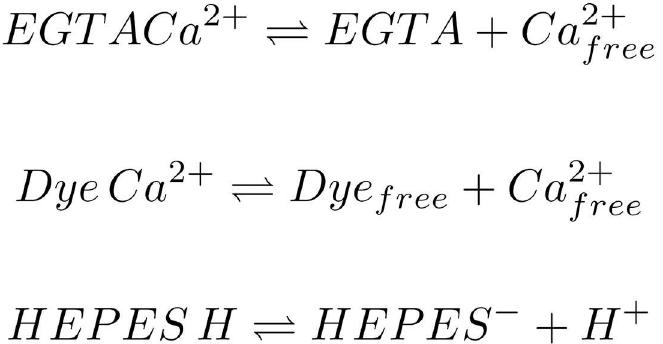
Fig 4. Most important equilibrium reactions in the solution. Shown here are the EGTA-Calcium ion buffer reaction, the Dye-Calcium ion bindingreaction and the pH buffer reaction of HEPES. The reaction equilibria are influencedby pressure, temperature, pH and concentration of the components. The whole reaction system influences the observable fluorescence